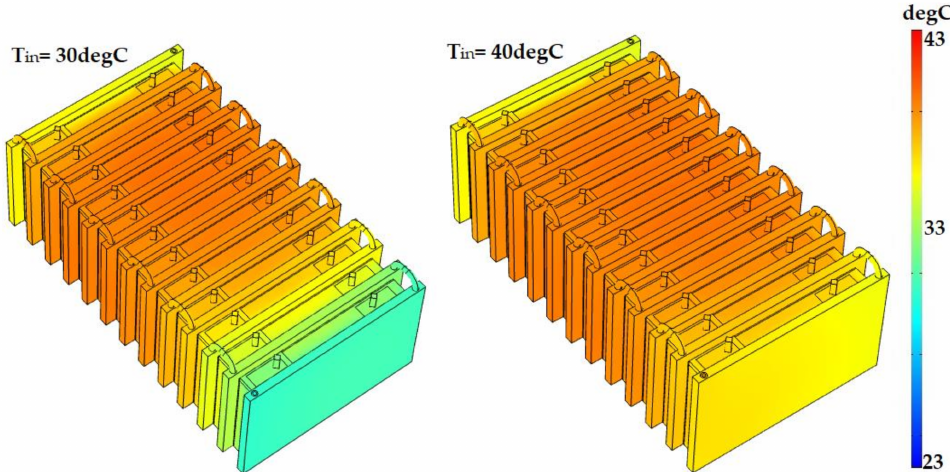
Figure 15. The temperature distribution of the module with different inlet temperatures.